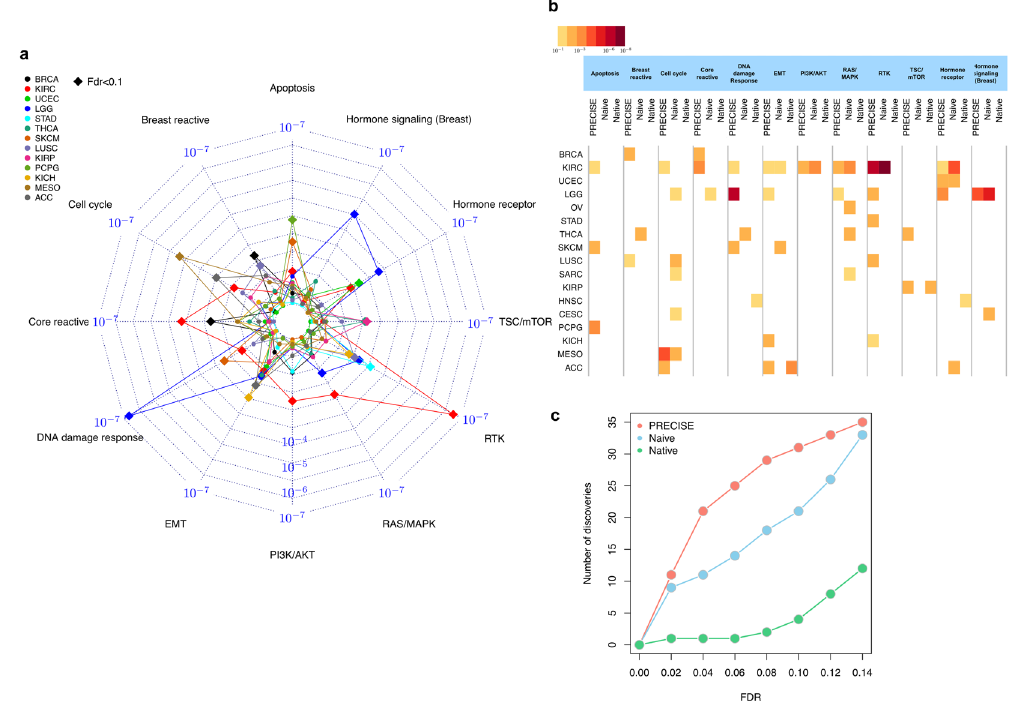
Figure 5. Supervised learning with survival times based on PRECISE scores. ( a ) Radar plot for p-values for PRECISE statuses (suppressed, neutral, or activated) using log-rank test for survival times. ( b ) Heatmap for p-values (high-to-low) with FDR < 0.1 across all 17 cancer types that provides p-values with FDR < 0.1 for at least one pathway and all the pathways, and three different methods, PRECISE, naïve and native. ( c ) The number of discoveries for the three different methods according to various FDR